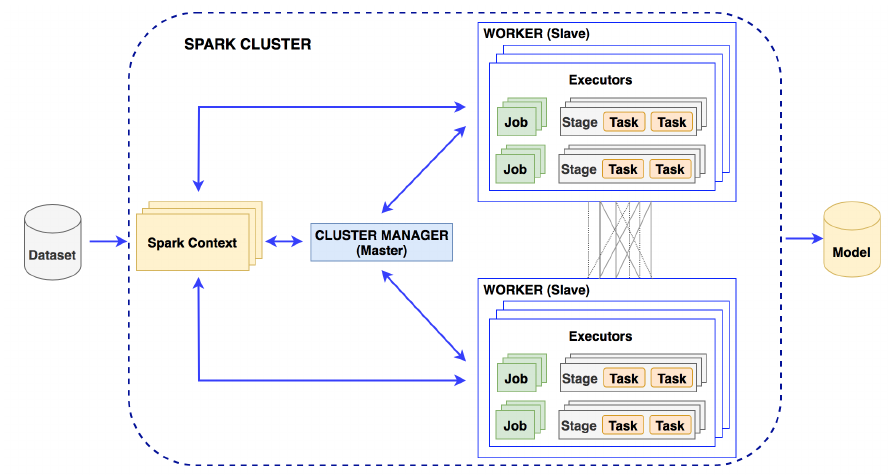
Figure 7. Training phase in a Spark